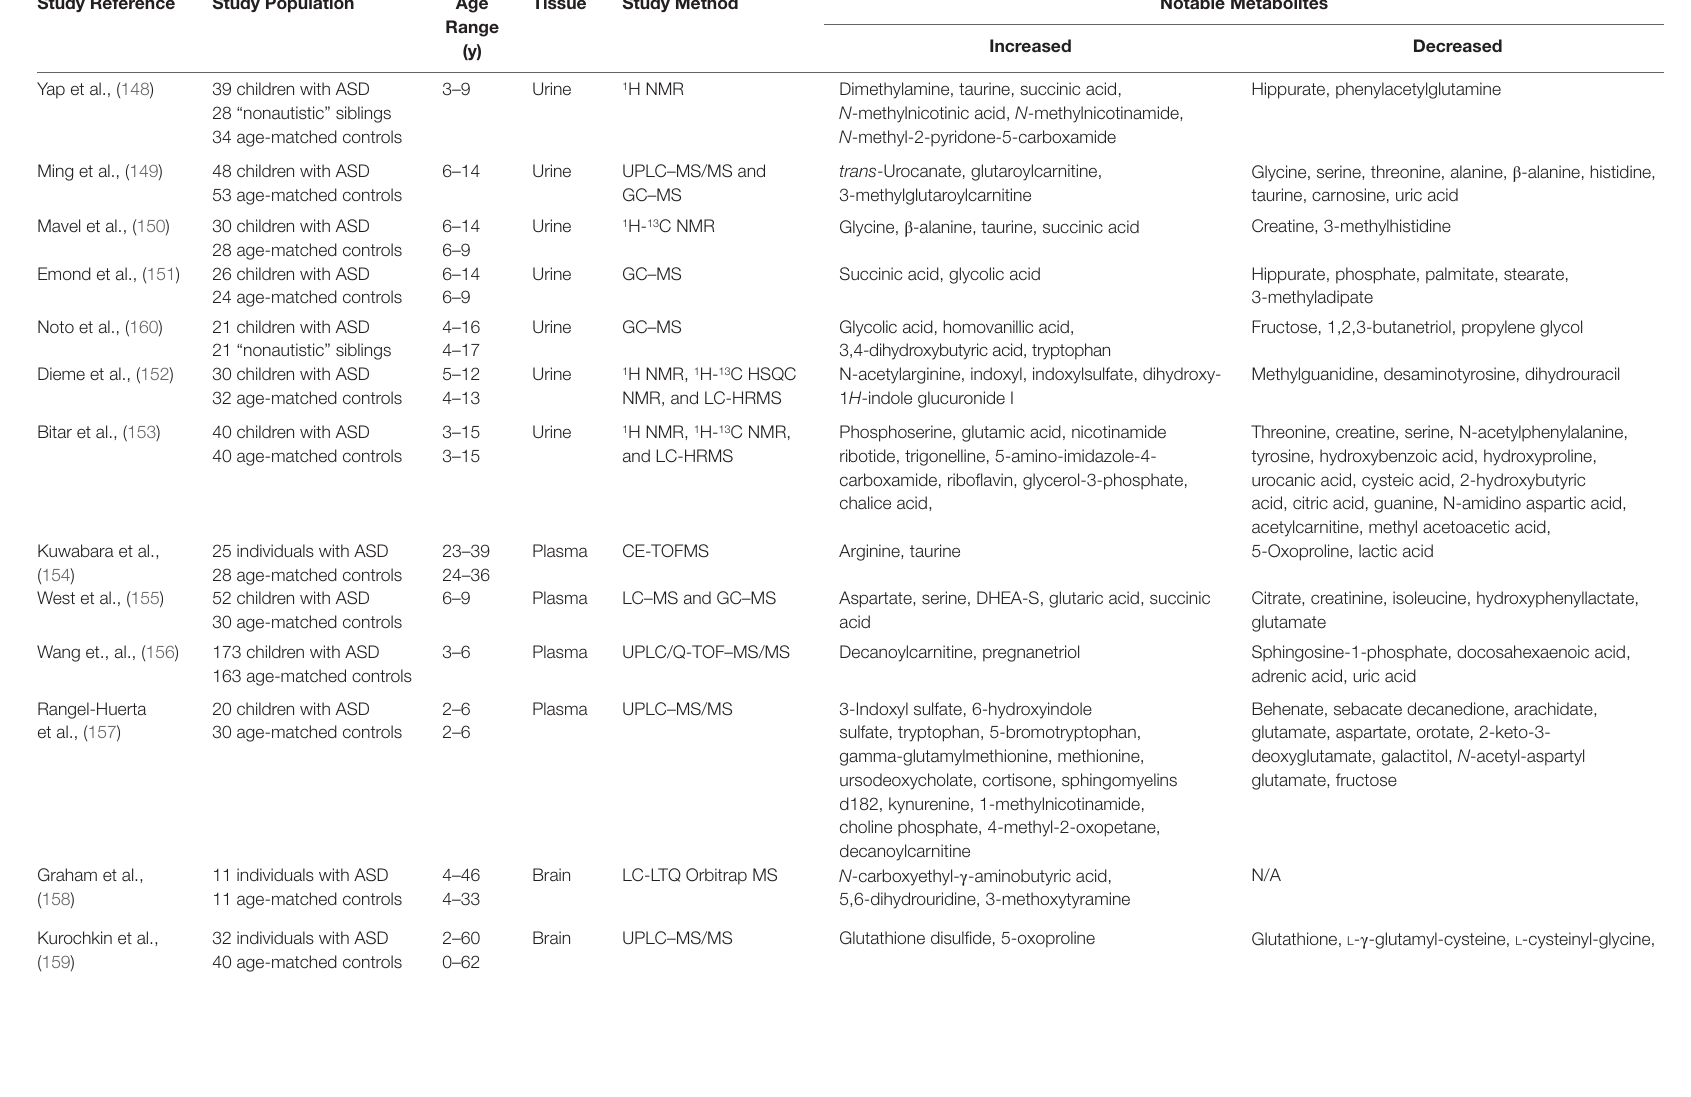
TABLE 1 | Previous studies utilizing untargeted metabolomics in subjects with autism spectrum